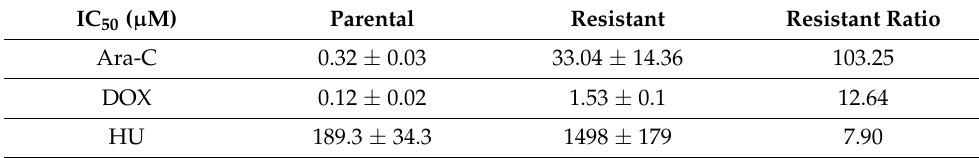
Table 2. Statistics of MTT IC 50 values.